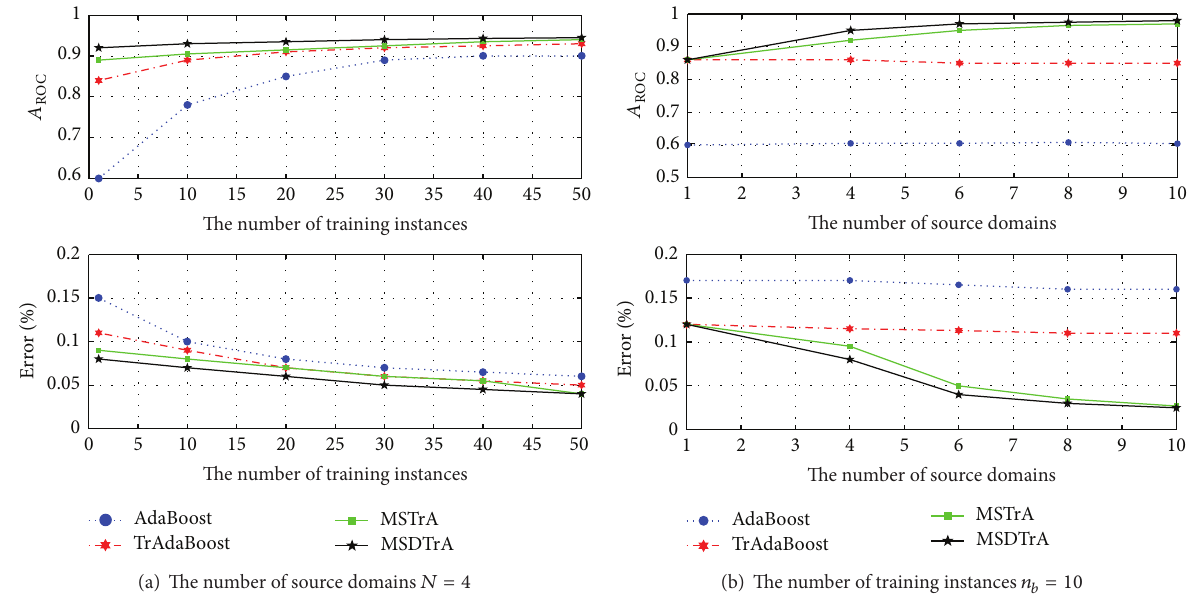
Figure 1: Performance comparison.